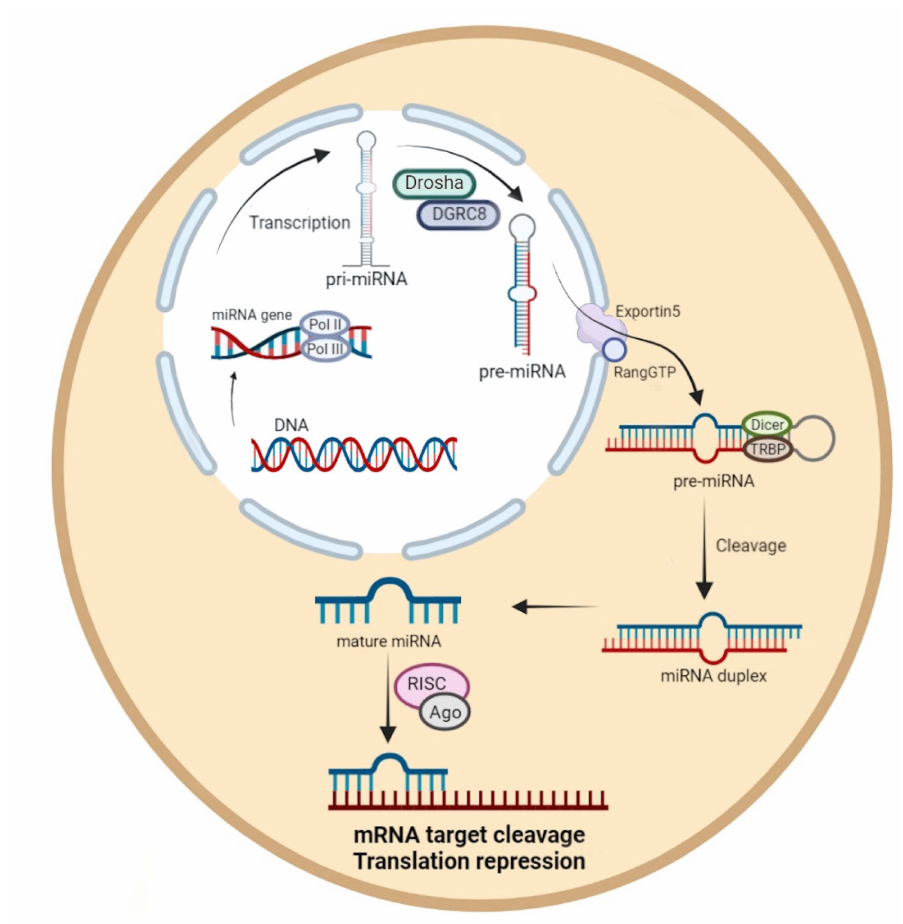
Figure 1. Biogenesis and functions of microRNA in humans and animals. MiRNA genes are tran- scribed in the cell nucleus to pri-miRNA, then, transformed to pre-miRNA by Drosha. Then, the pre-miRNA is transported to the cytoplasm by Exportin5 and cleaved to create an miRNA duplex containing the mature miRNA. After strand separation, the single-stranded mature miRNAs are incor- porated into the miRNA-induced silencing complex. The resulting complex mediates the recognition of target mRNA and participates in gene silencing via translation repression or mRNA